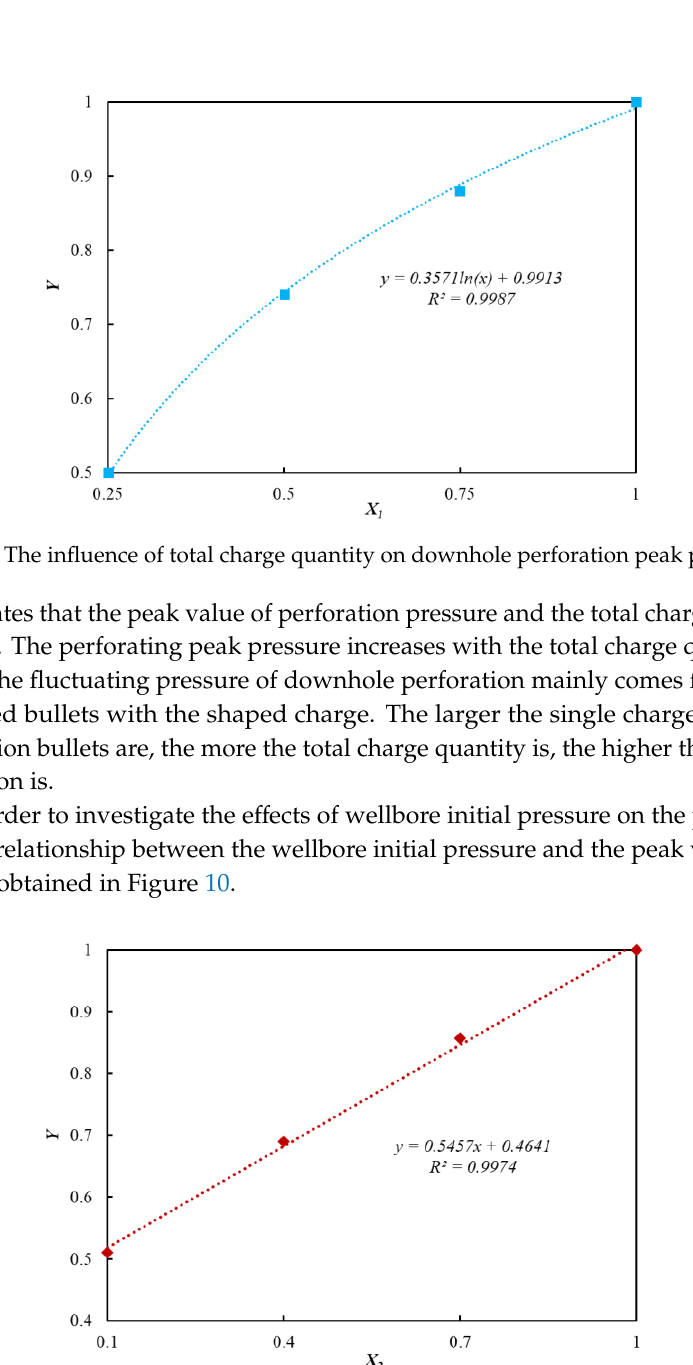
Figure 11. The influence of downhole perforation effective volume on perforation peak pressure. The relationship between the thickness of casing and cement and the peak value of downhole perforating pressure can be drawn, as shown in Figure 12. It can be seen that the peak value of downhole perforating pressure and the thickness of casing and cement show a power relation function. The peak value of downhole perforating pressure gradually becomes smaller with the increase of the thickness of casing and cement. The reason is that with the increase of energy used to perforate casing and cement, the explosive energy released in wellbore decreases correspondingly. The pulsating pressure of perforation decreases accordingly.